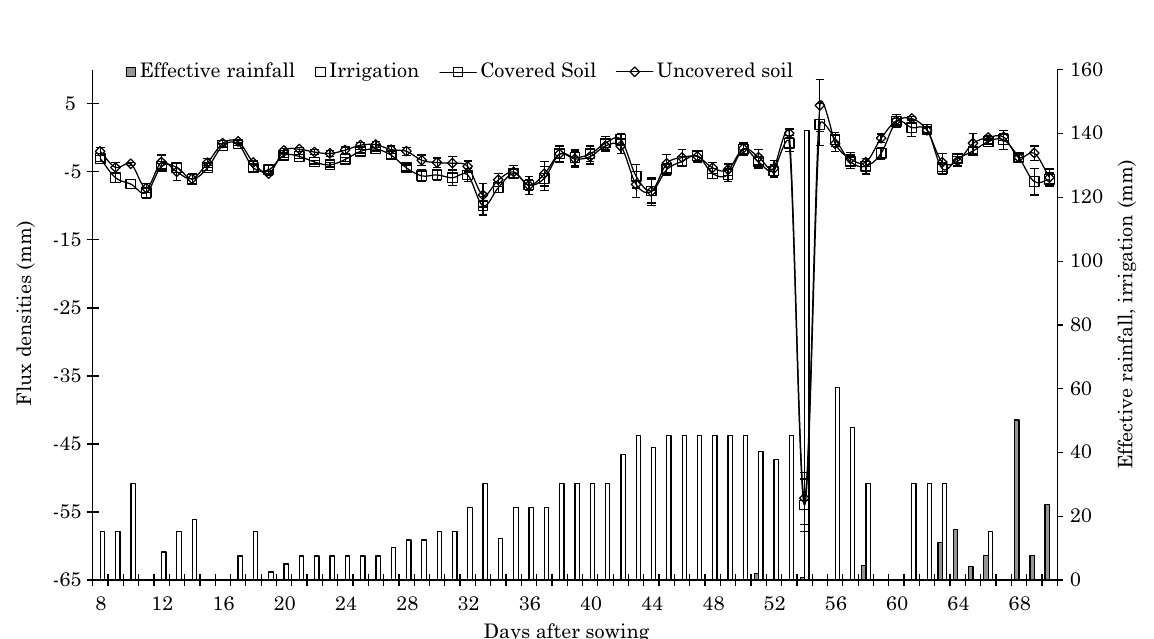
Figure 6. Average daily flux density, with the correspondent standard deviations, rainfall, and irrigation throughout the muskmelon cycle (negative values indicate internal drainage; positive values indicate capillary